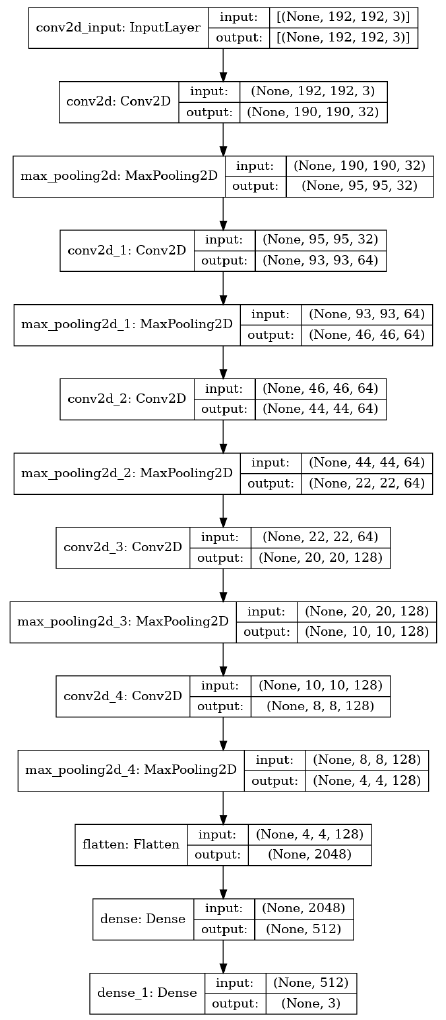
Figure A1. Diagram of a basic Convolutional Neural